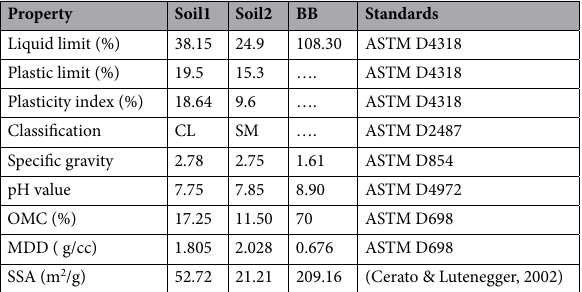
Table 1. Basic physical properties, classification, fineness and compaction characteristics of soils and biochar used in the study. BB bamboo biochar, OMC optimum moisture content, MDD maximum dry density, SSA specific surface area, CL low plastic clay, SM silty